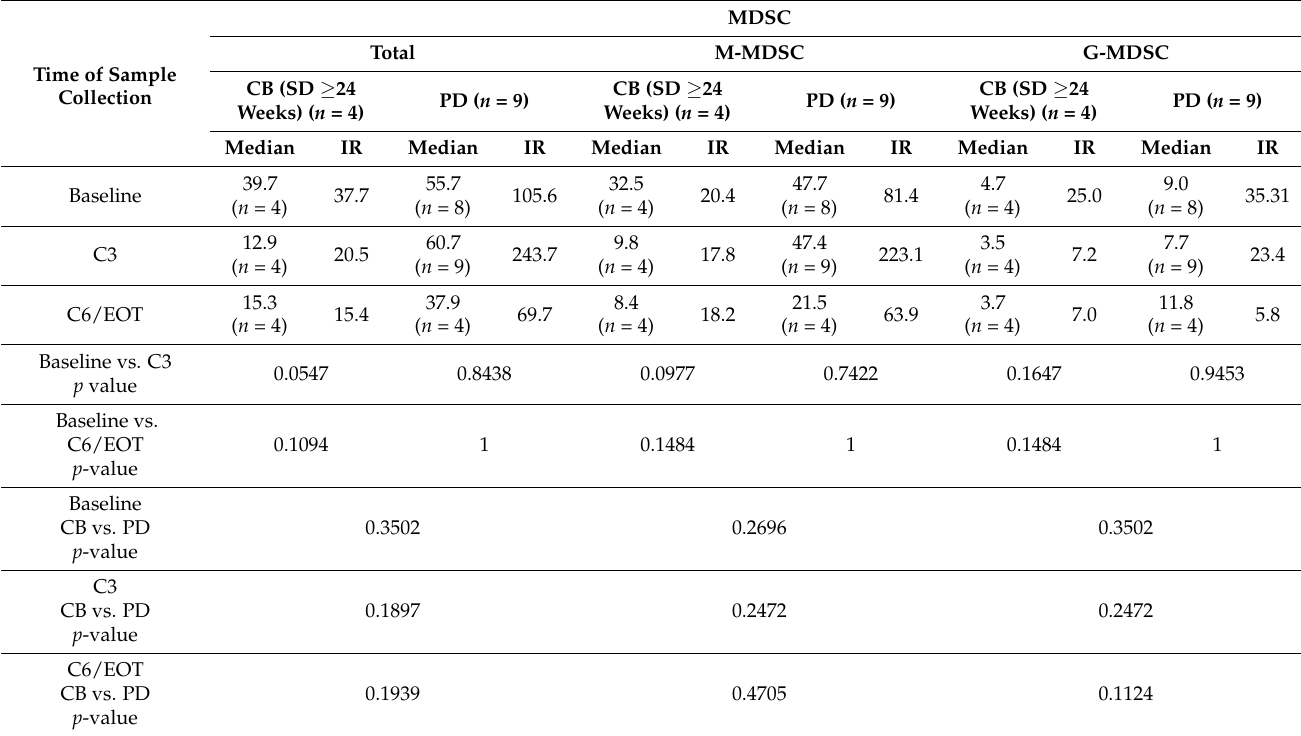
Table 4. MDSCs levels (cells/ µ L) according to tumor